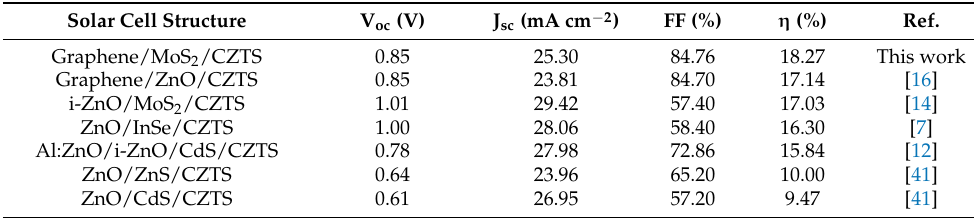
Figure 10. The J–V characteristics of a CZTS solar cell. Table 2. Values were obtained from numerical analysis of the open-circuit voltage (V oc ), short-circuit current density (J sc ), fill factor (FF), and power conversion efficiency ( η